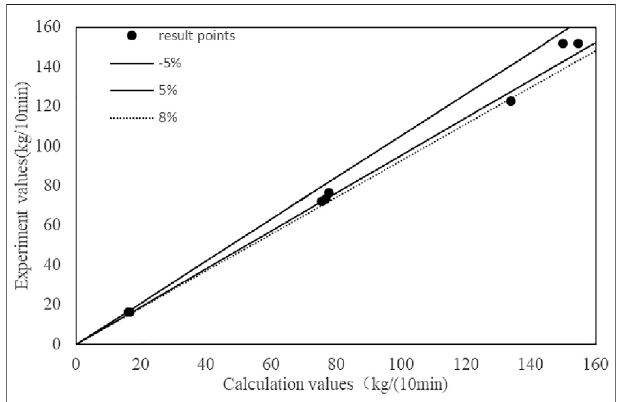
FIGURE6| Comparisonofsimulationresultsandtestresultsof fi lmloss.